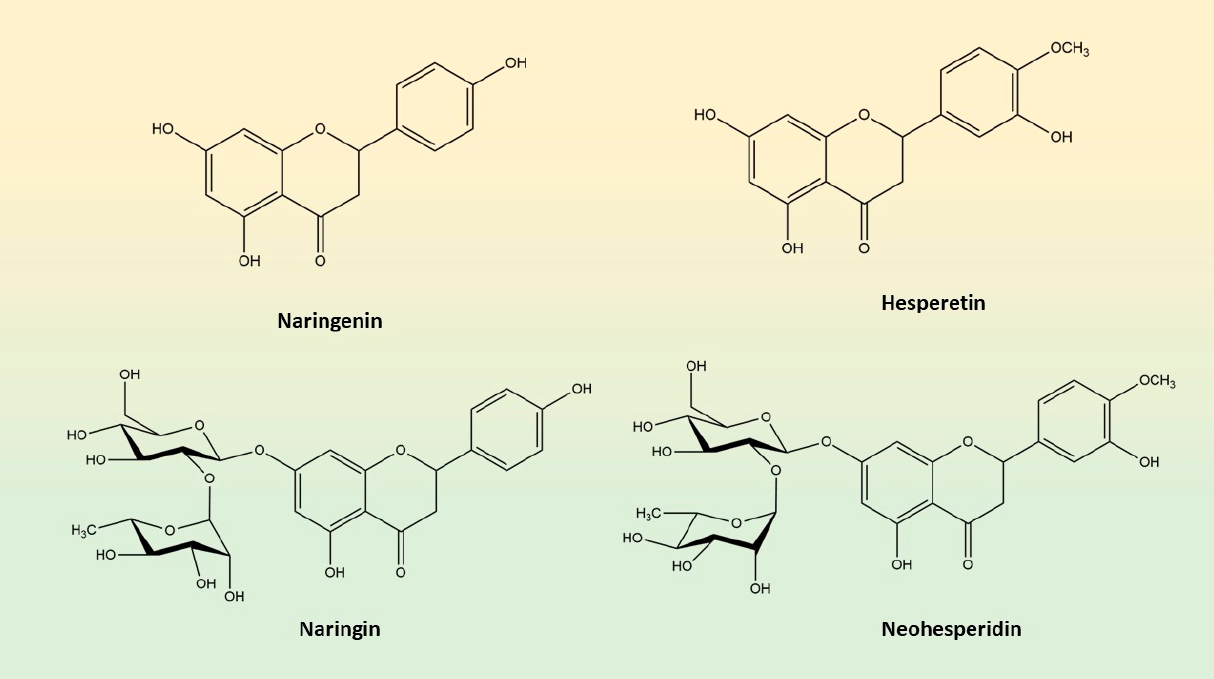
Figure 1. Chemical structures of the main flavanones present in Citrus